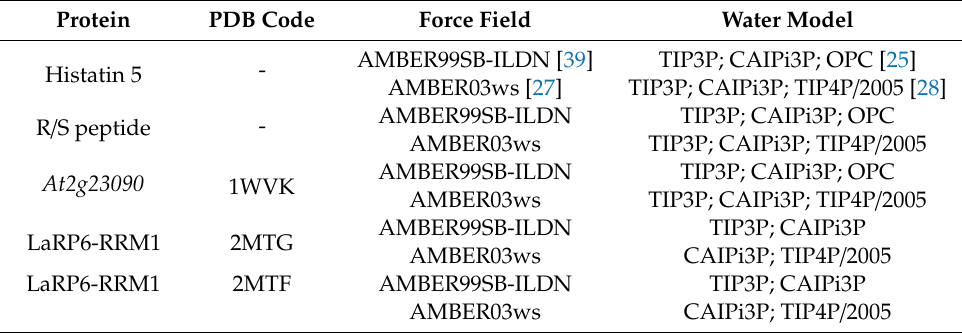
Table 7. Macromolecules simulated and their respective force field / solvent combinations. Protein PDB